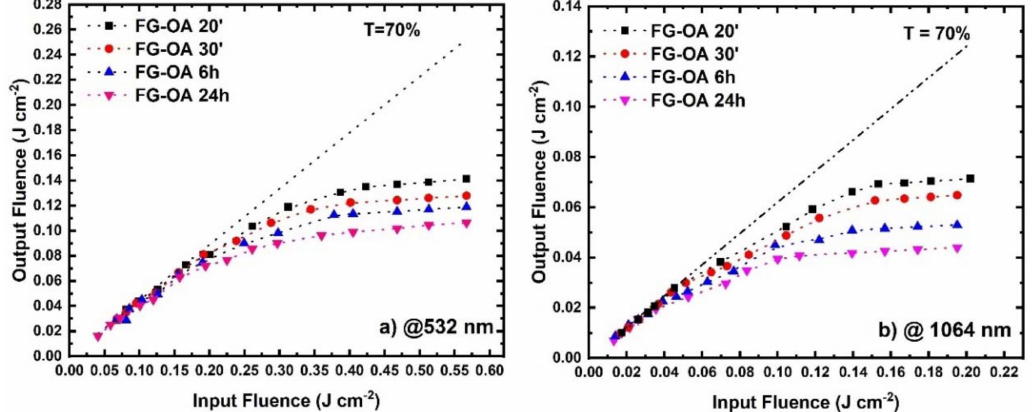
Figure 4. Optical limiting action of FG-OAxs under ( a ) 532 and ( b )1064 nm laser